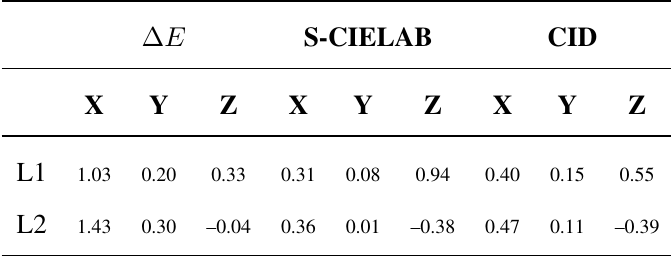
Error in a least-squares optimization minus error using a spherical sampling procedure computed in the sensor